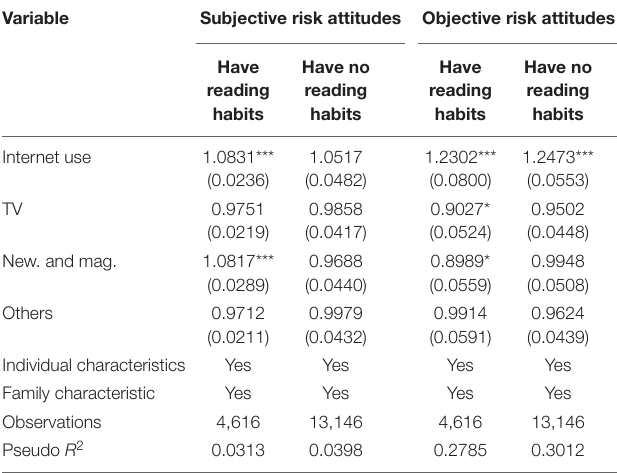
TABLE 8 | Heterogeneity of the learning